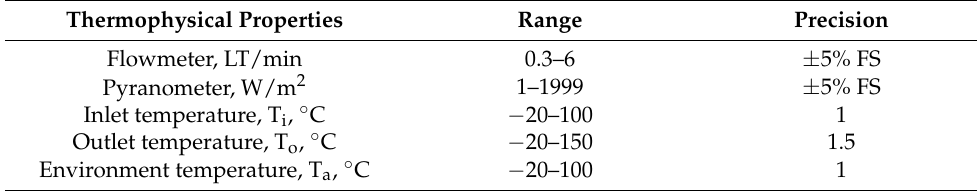
Table 3. Specifications of measuring